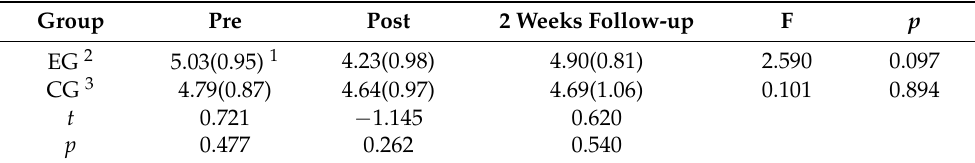
Table 7. Changes in step time by the period.